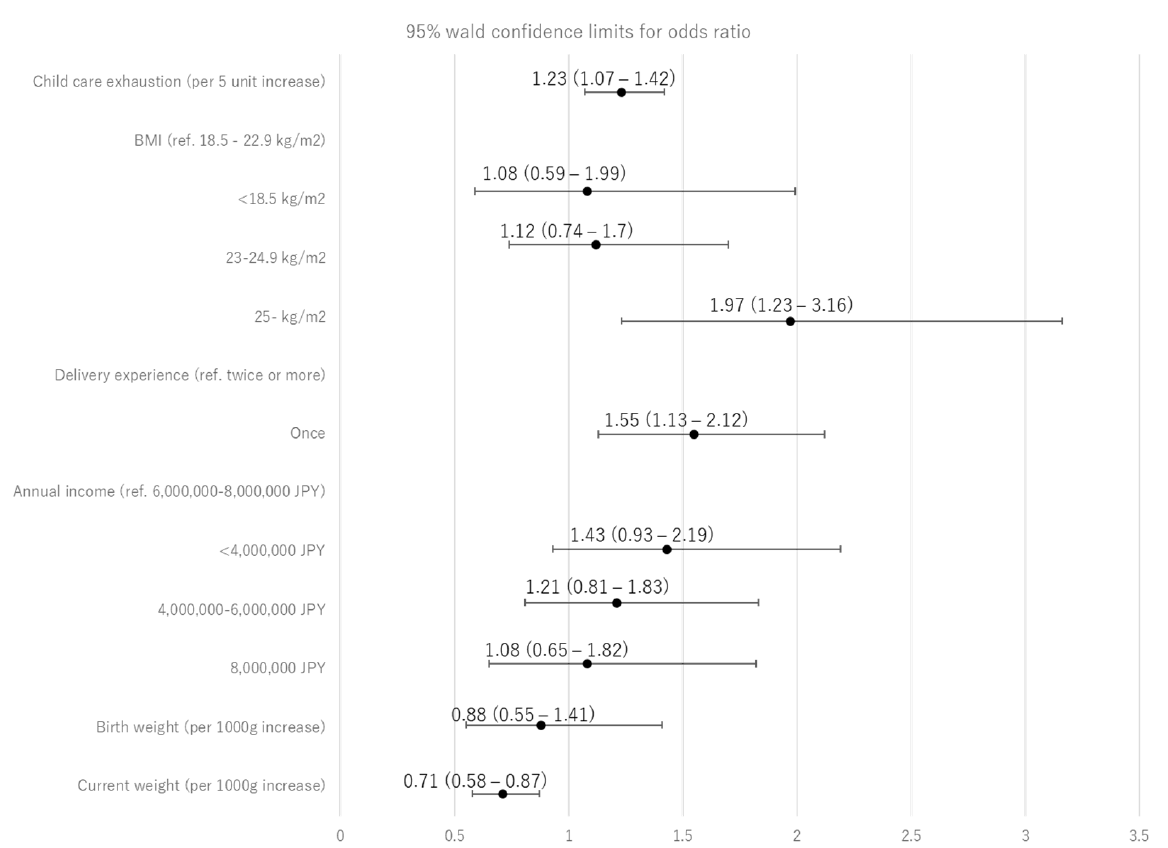
Figure 2. Adjusted odds ratios of partial breastfeeding at two months (Model 1: childcare exhaus- tion model).